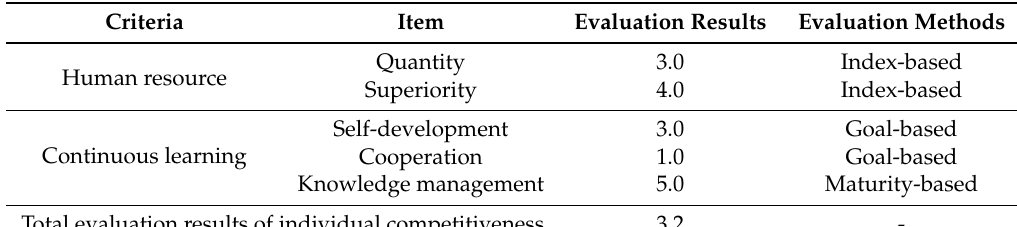
Table 9. Results of analysis on individual competitiveness—Department B.